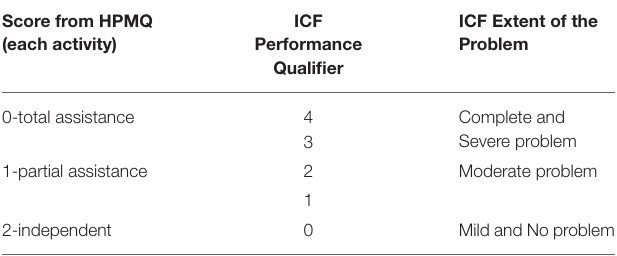
TABLE 5 | Activity Level (AL) of patients in NEMP admission and discharge.